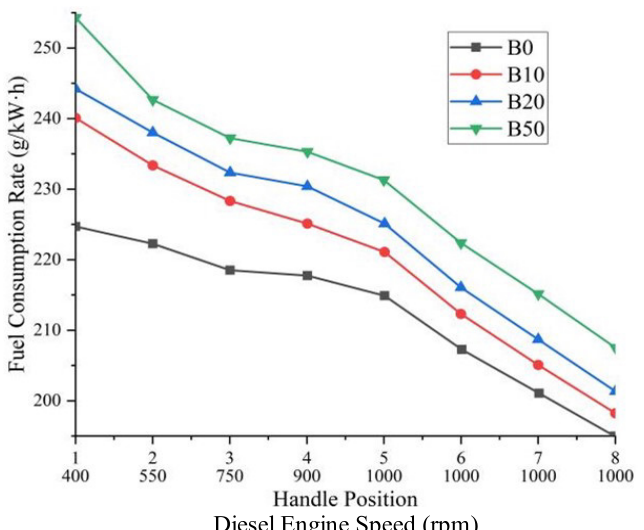
Figure 4. The fuel consumption curve of biodiesel with various ratios at different